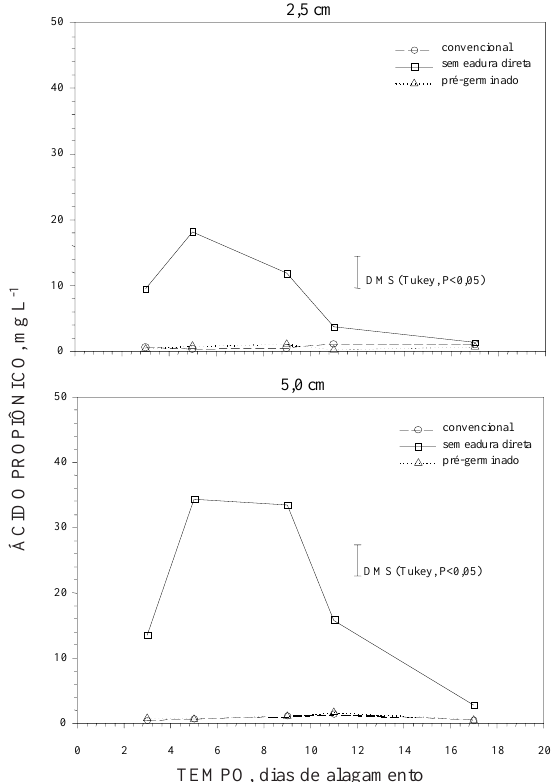
Figura 3. Concentração de ácido propiônico na solução de um Gleissolo, em duas profundidades (2,5 e 5,0 cm), em três sistemas de cultivo de arroz durante 17 dias de alagamento do solo.